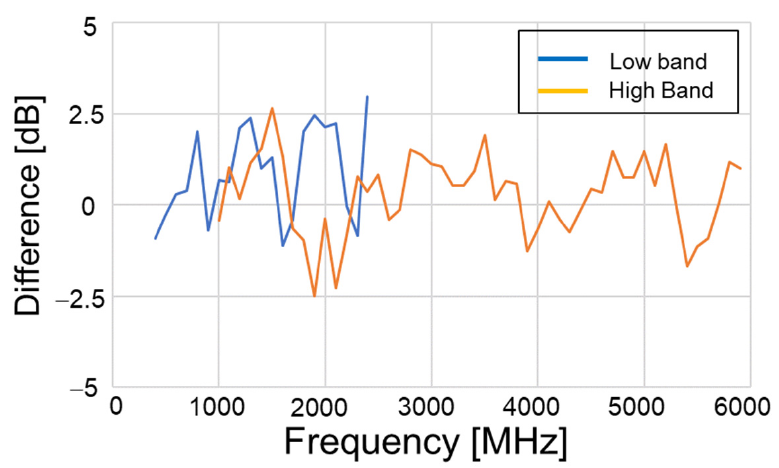
Figure 2. Measured and calculated E-fields.